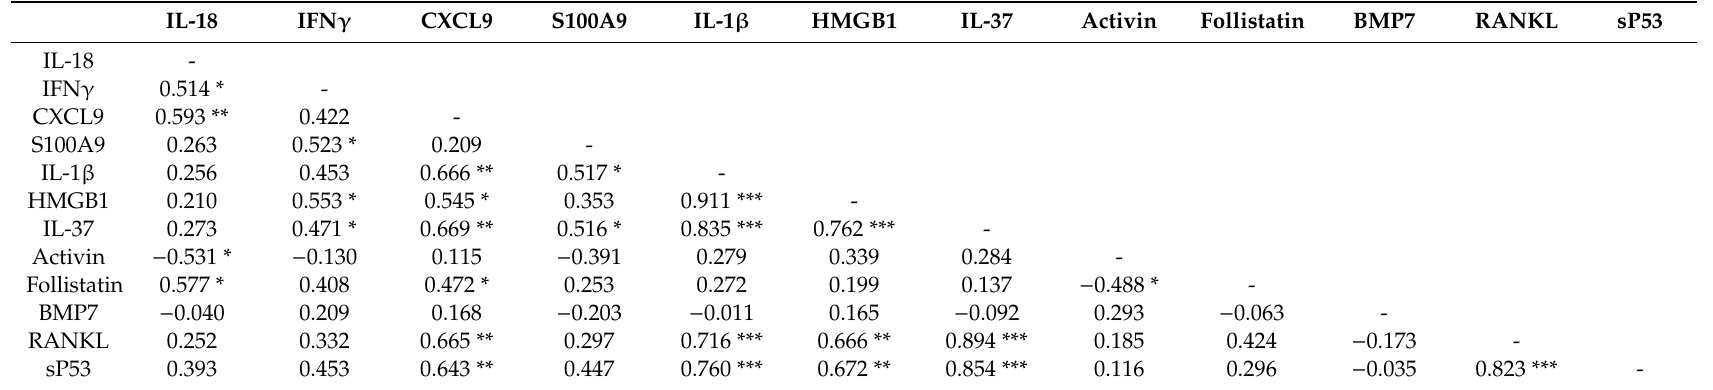
Table 3. Correlation matrix (Spearman rank-correlation coe ffi cients) of baseline serum cytokines levels with each